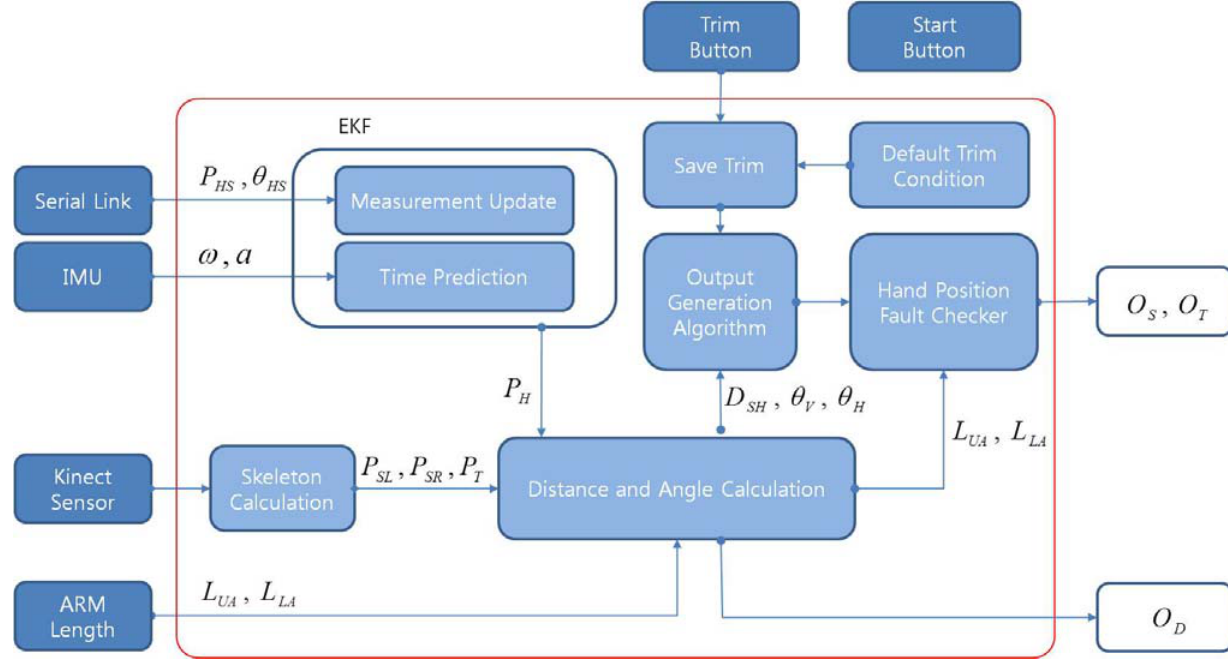
Figure 7. Block diagram of the intelligent lead.